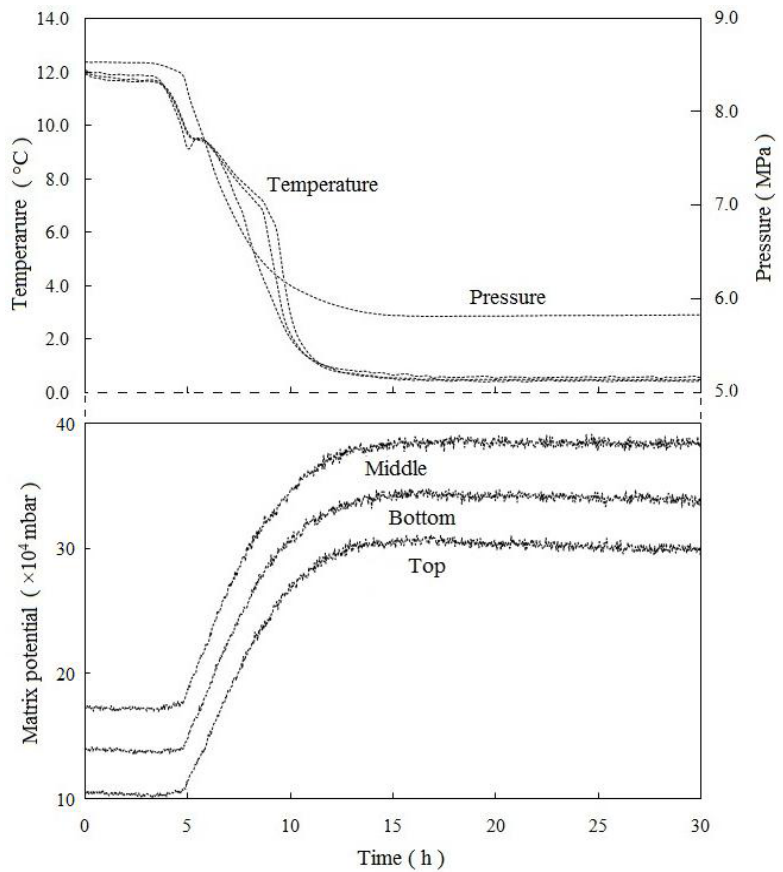
Figure 4. Changes in temperature, pressure, and matrix potential as functions of time in silica